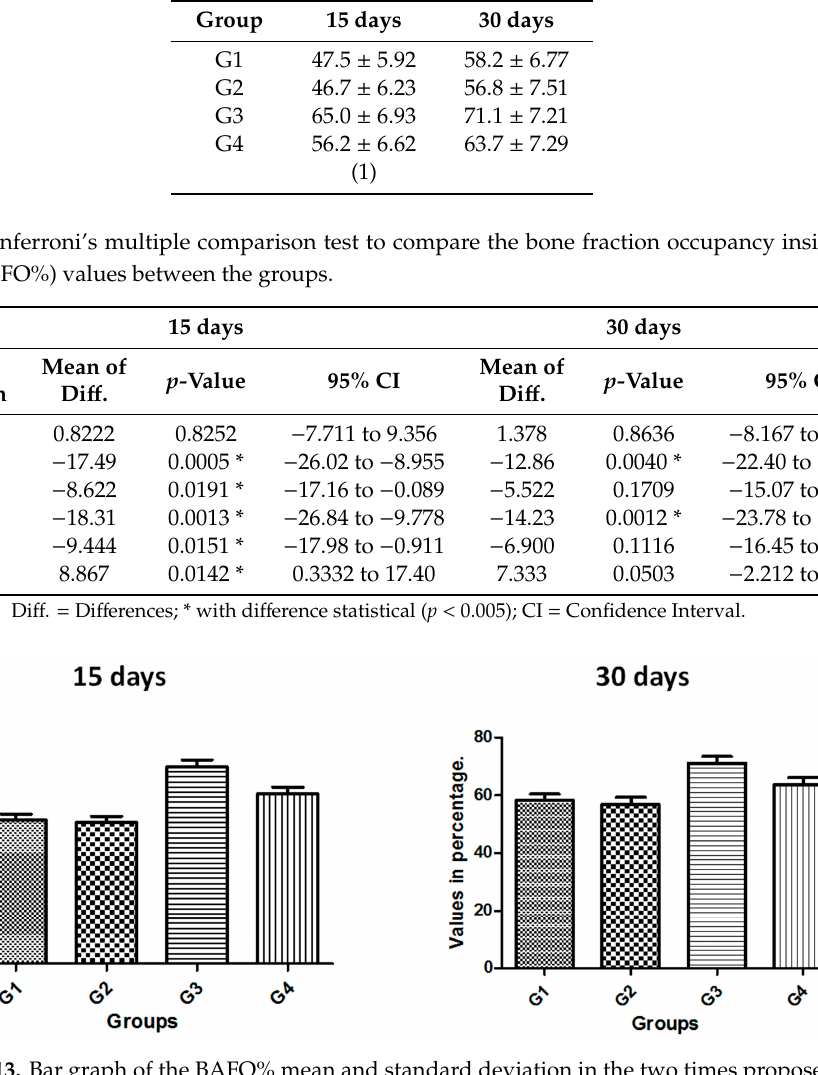
Figure 12. Bar graph of the BIC% mean and standard deviation in the two times proposed. Table 7. Table data (mean, standard deviation, and median) and graph values distribution of the bone-to-implant contact percentage (BIC%) measured around the surface of each sample. Group 15 days